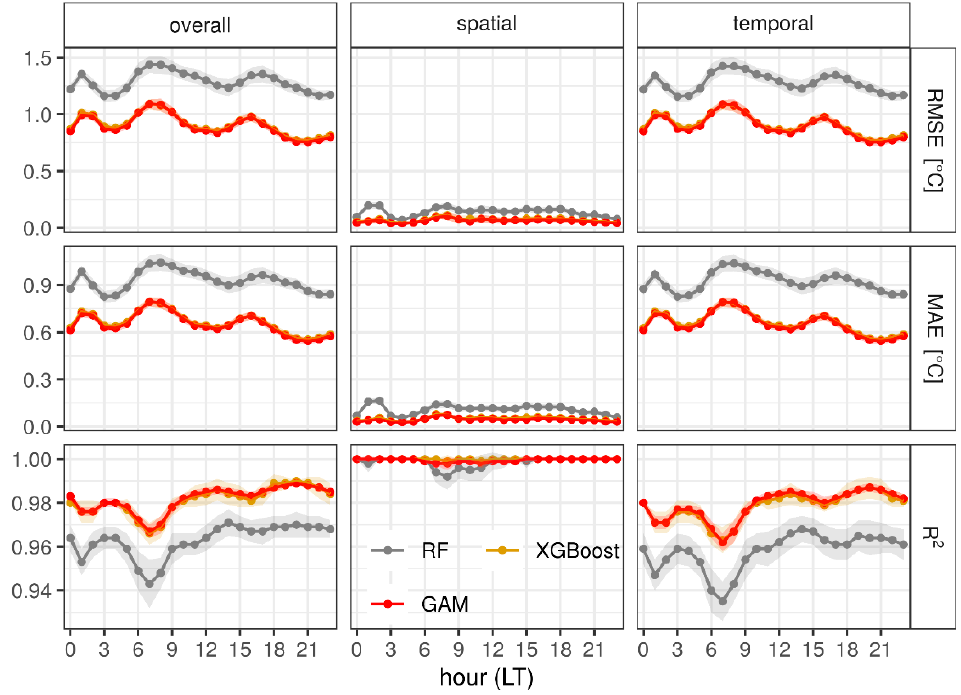
Figure 10. The 5-fold cross-validated performance (RMSE, MAE, R 2 ) of individual models in Stage 2: overall and disaggregated by spatial and temporal components. The error band indicates the standard deviation.